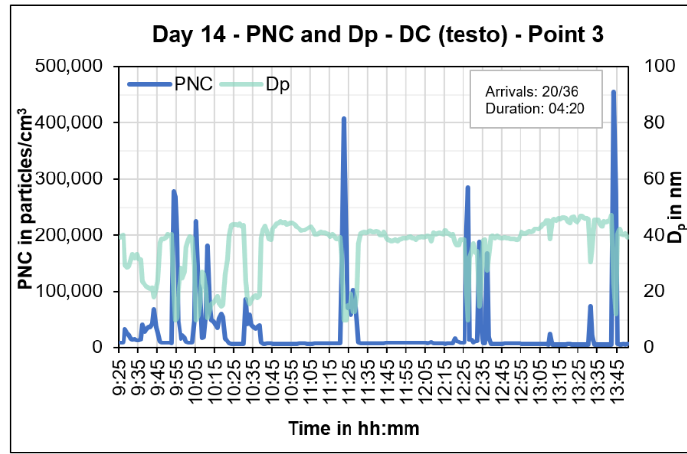
Figure 14. Day 14 PNC and D p results.